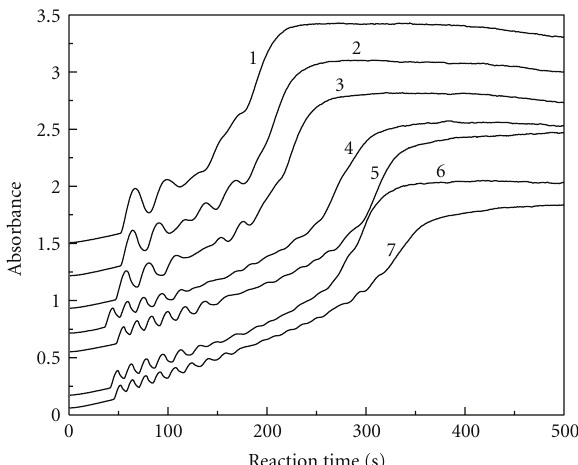
Figure 6: The absorbance versus reaction time at 289 nm for the triiodide ion: [ClO 2 ] 0 /[KI] 0 = 0.115, [MAA] 0 = 6.29 × 10 − 3 mol/L, [H 2 SO 4 ] 0 = 3.50 × 10 − 3 mol/L, [ClO 2 ] 0 = 4.01 × 10 − 4 mol/L, [KI] 0 = 3.48 × 10 − 3 mol/L (curve 1); [ClO = 4.21 × 10 − 4 mol/L, [KI] 2 ] 0 0 = 3.65 × 10 − 3 mol/L (curve2); [ClO = 4.40 × 10 − 4 mol/L, [KI] = 2 ] 0 0 3.82 × 10 − 3 mol/L (curve 3); [ClO 2 ] 0 = 4.60 × 10 − 4 mol/L, [KI] 0 = 3.99 × 10 − 3 mol/L (curve 4); [ClO 2 ] 0 = 4.70 × 10 − 4 mol/L, [KI] 0